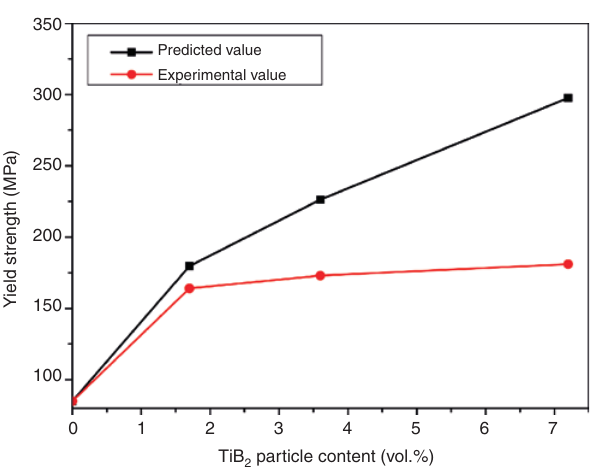
Figure 7: Theoretically calculated yield strength using the arithme- tic summation